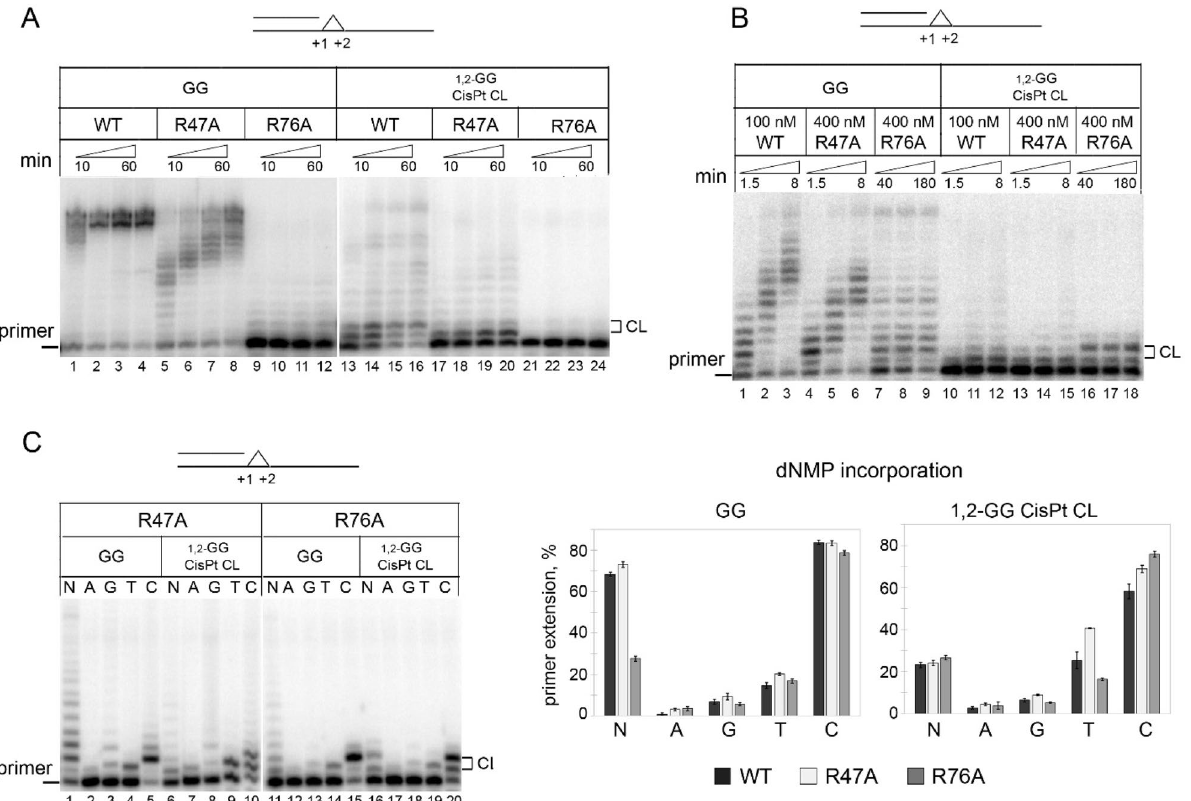
Figure 3. The TLS activity of the R47A and R76A PrimPol variants on DNA substrates with the 1,2-GG CisPt CL. ( A ) The DNA polymerase activity of PrimPol mutant variants on DNA substrates with the 1,2-GG CisPt CL or undamaged GG at the + 1–2 positions. Reactions were carried out in the presence of 200 nM wild-type PrimPol or 200 nM of mutant PrimPol variant for 10, 20, 40 or 60 min. ( B ) The adjusted DNA polymerase activity of PrimPol mutant variants on DNA substrates with the 1,2-GG CisPt CL or undamaged GG at the + 1–2 positions. Reactions were carried out in the presence of 100 nM wild-type PrimPol for 1.5, 4 or 8 min, 400 nM R47A variant for 1.5, 4 or 8 min and 400 nM R76A variant for 40, 80 and 180 min. ( C ) dNMPs incorporation opposite undamaged GG or 1,2-GG CisPt CL by the R47A and R76A PrimPol variants. Reactions were